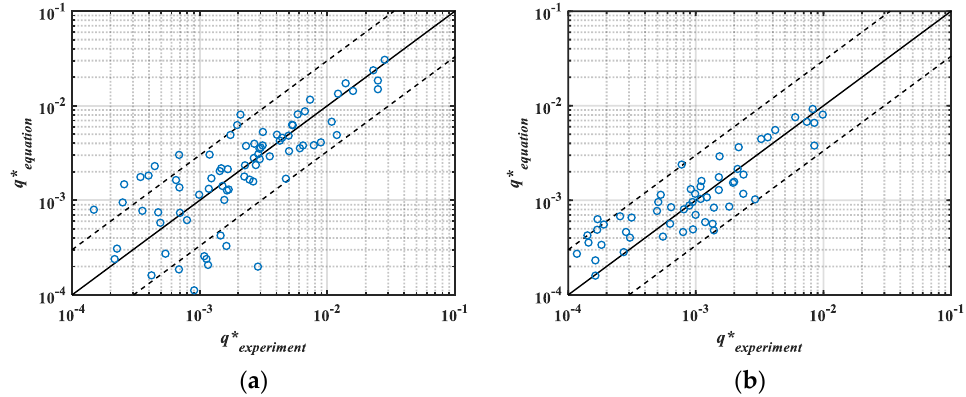
Figure 25. Scatter diagrams of the measured and predicted mean wave overtopping discharge over the seawalls: ( a ) regular wave; ( b ) irregular